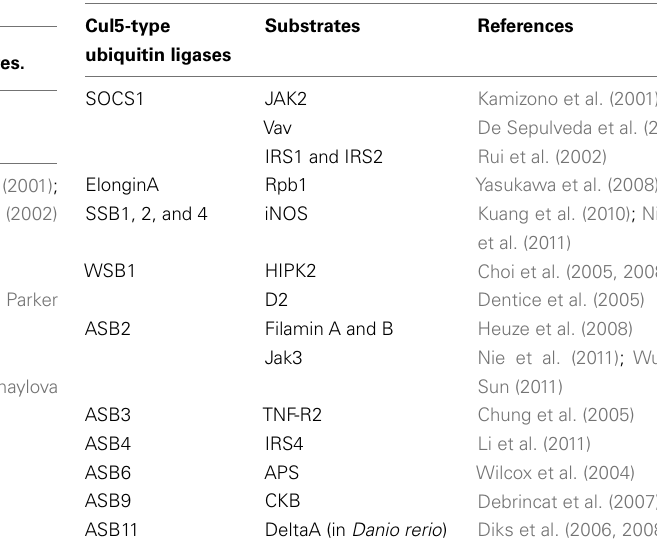
Table 2 | Cul5-type ubiquitin ligases and corresponding